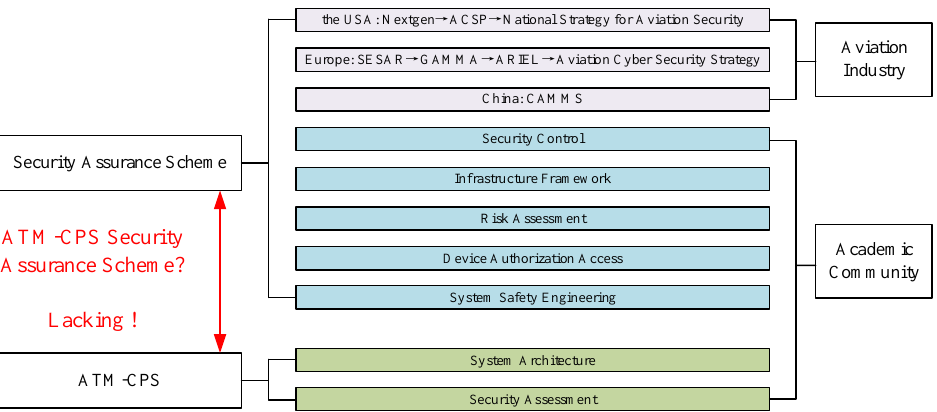
Figure 2. Deficiencies in related work.